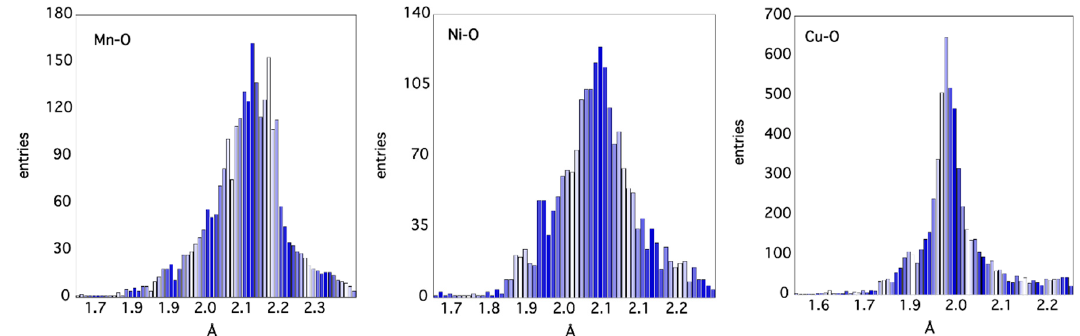
Figure 4. Bond lengths investigation within inorganic structures performed via open chemistry